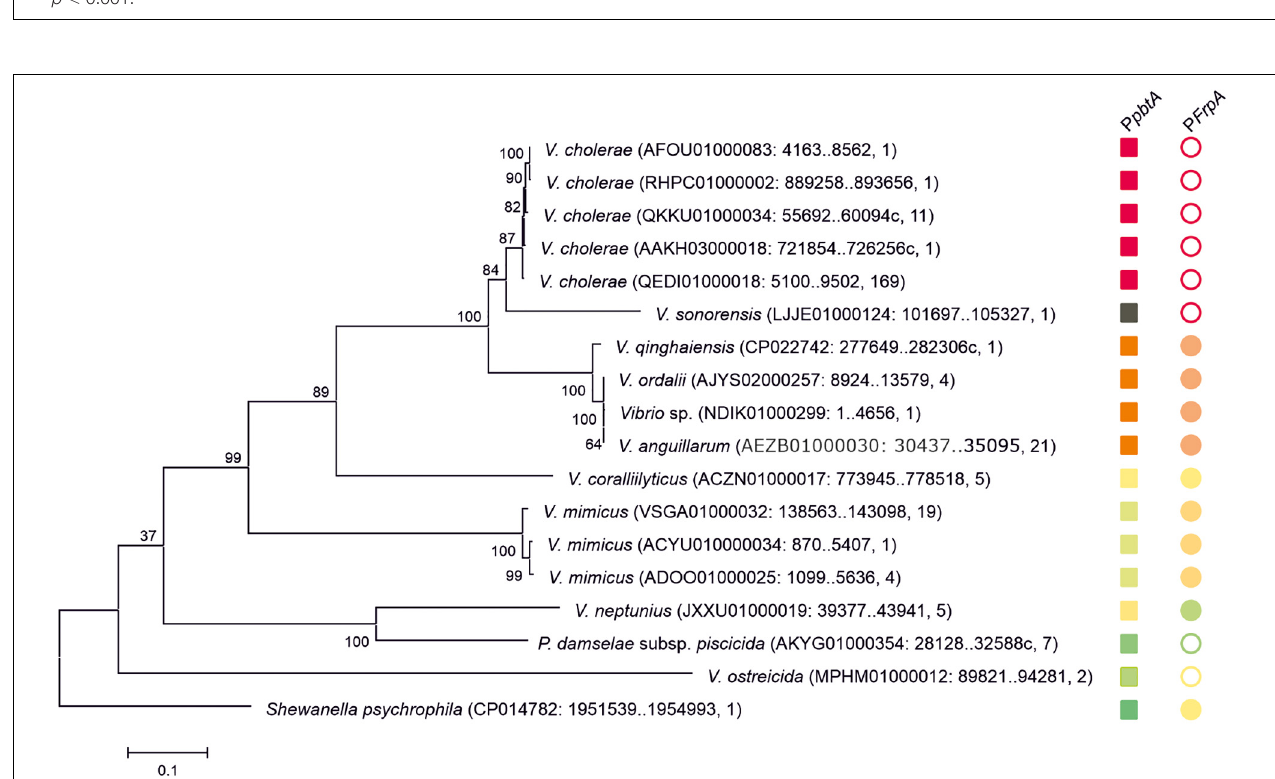
FIGURE 5 | Transcriptional activity of the promoters P pbtA and P frpA in either pbtA , pbtB, toxR-S , and h-ns mutant strains measured under weak iron deprivation (CM9 supplemented with 25 µ M 2,2 (cid:48) -dipyridyl). A t -test was used to detect significant differences between each mutant and the parental strain. * p < 0.05; *** p < 0.001.